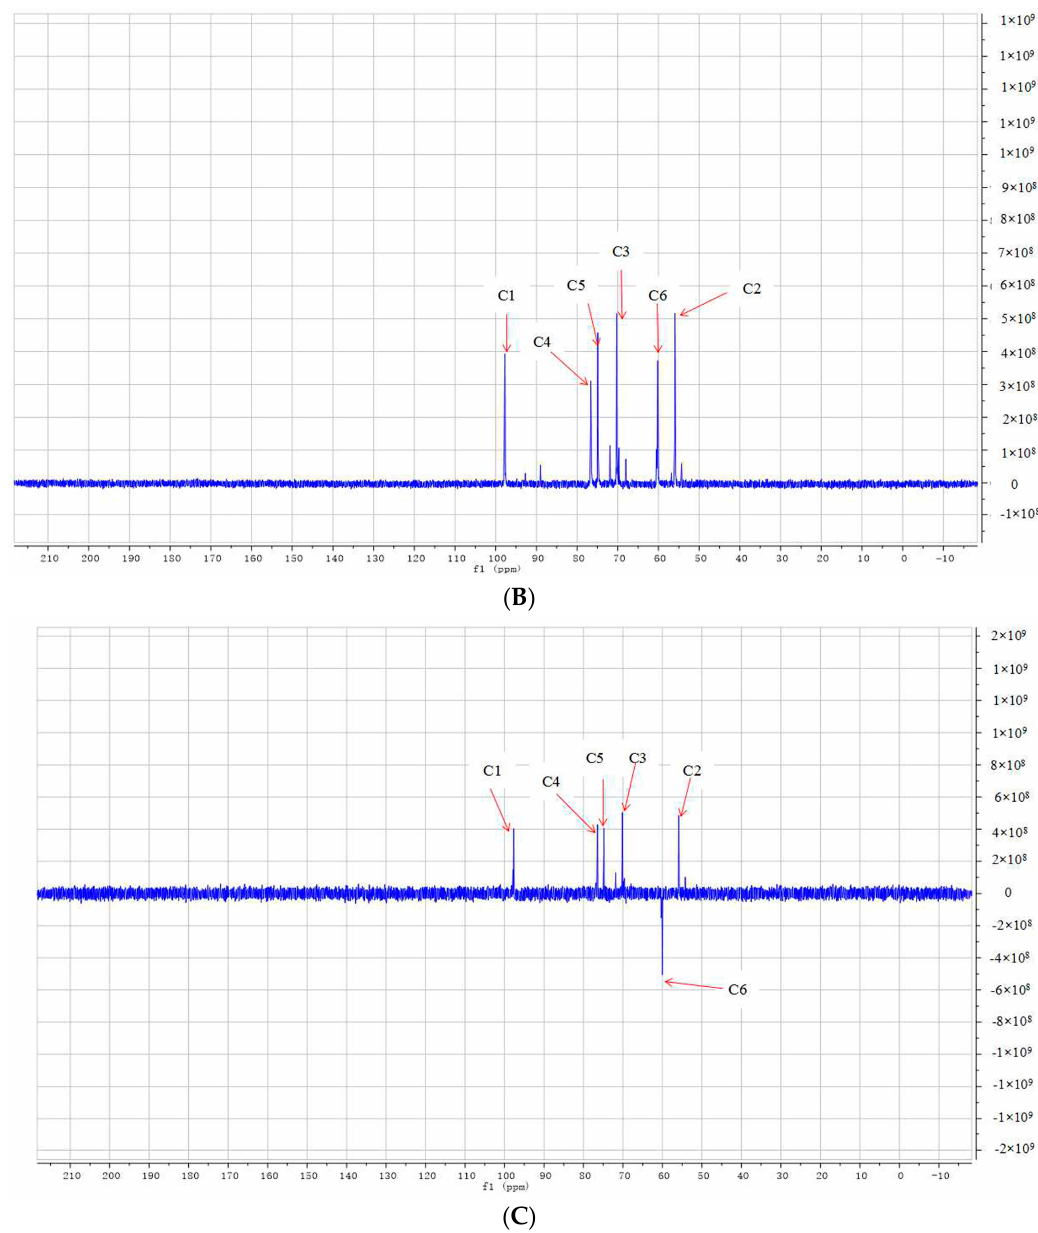
Figure 3. The spectra of: 1 H-NMR ( A ); 13 C-NMR ( B ); and DEPT-135 ( C ) of oligochitosan DP5. DP5 was dissolved in D 2 O at a concentration of 10 mg/mL. NMR, nuclear magnetic resonance; DEPT-135, distortionless enhancement by polarization transfer.